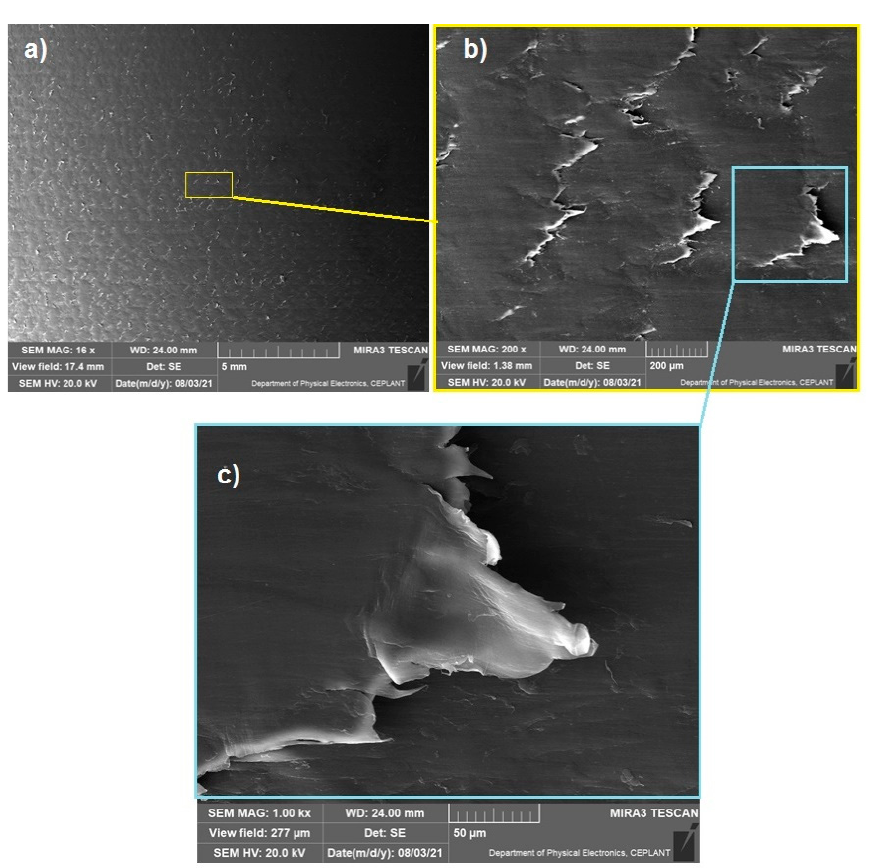
Figure 14. A detailed study of the surface topography at various magnifications. ( a ) machined surface, ( b , c )—production of “fish scales” on the surface.